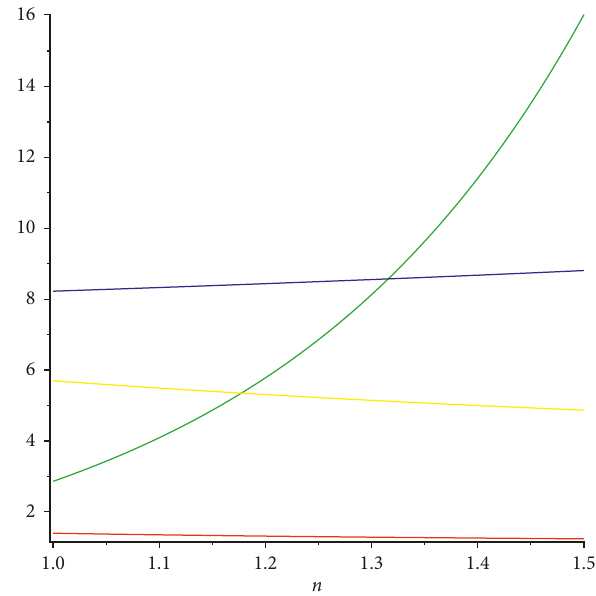
Figure 5: VAR of D